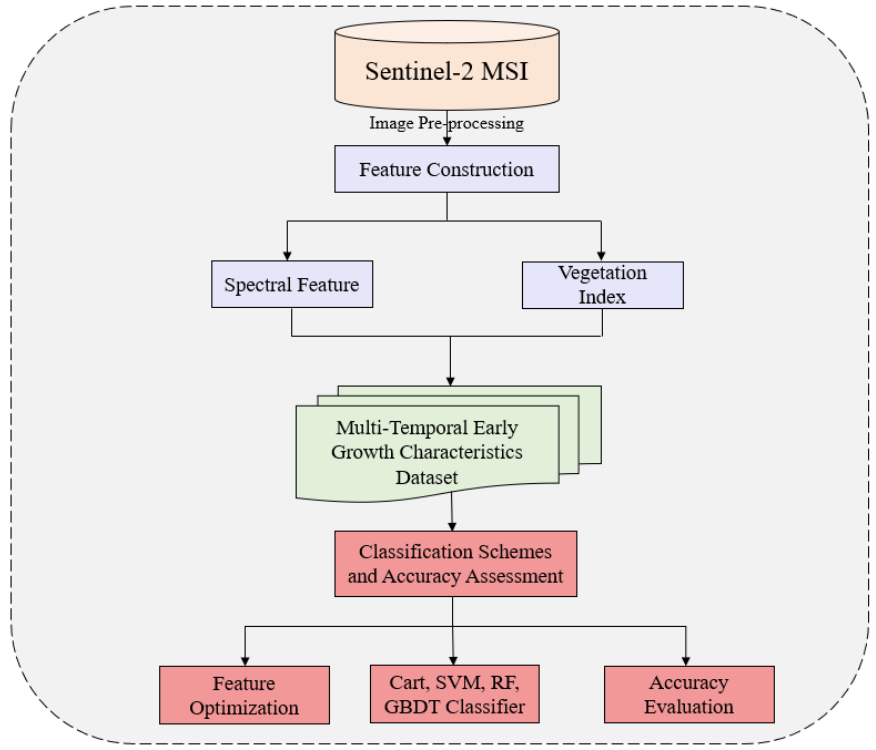
Figure 2. Workflow for early crop identification based on multi-temporal difference information. Table 3. Vegetation Index used in this study.